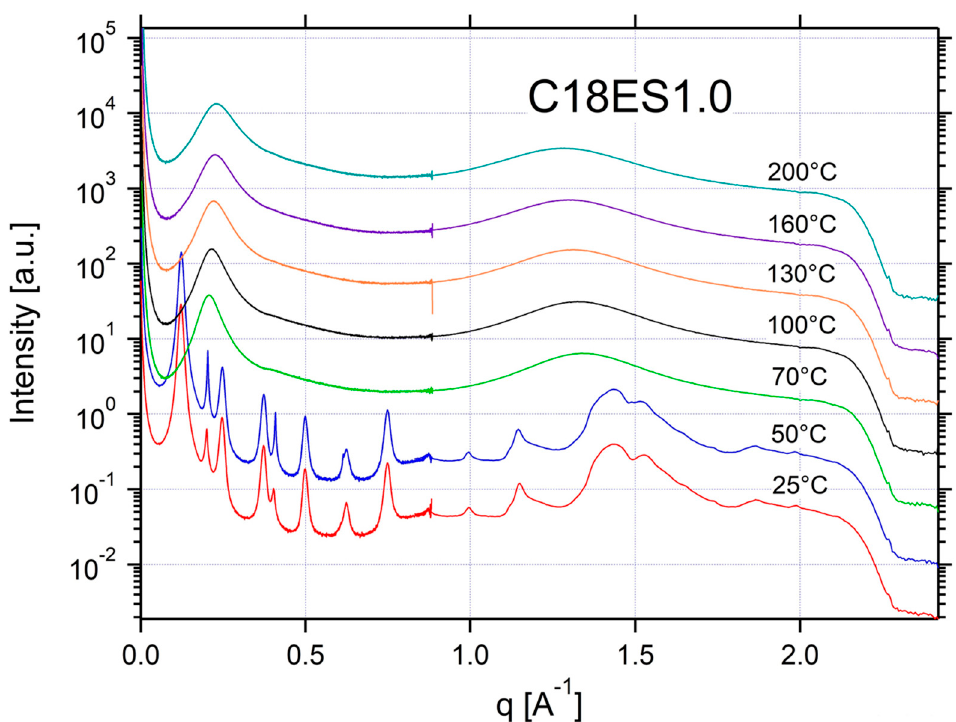
Figure A20. SAXS and WAXS data for 1:1 C18ES:C18LiTFSI.